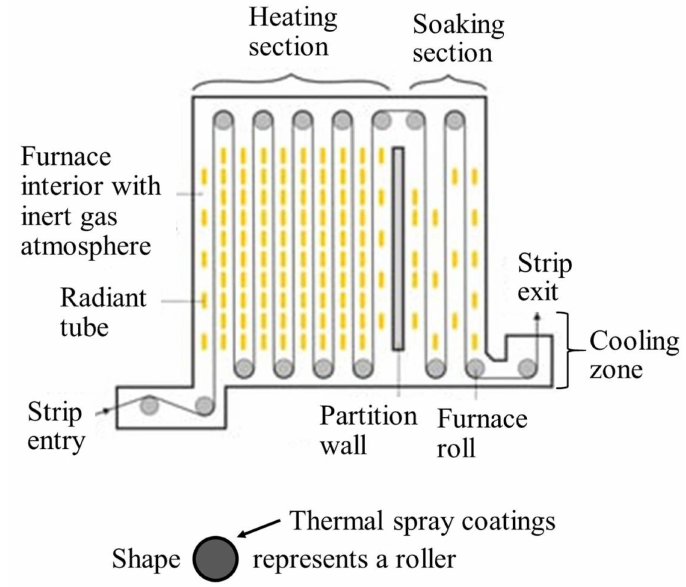
Figure 13. Different heating zones of annealing line. Adapted from